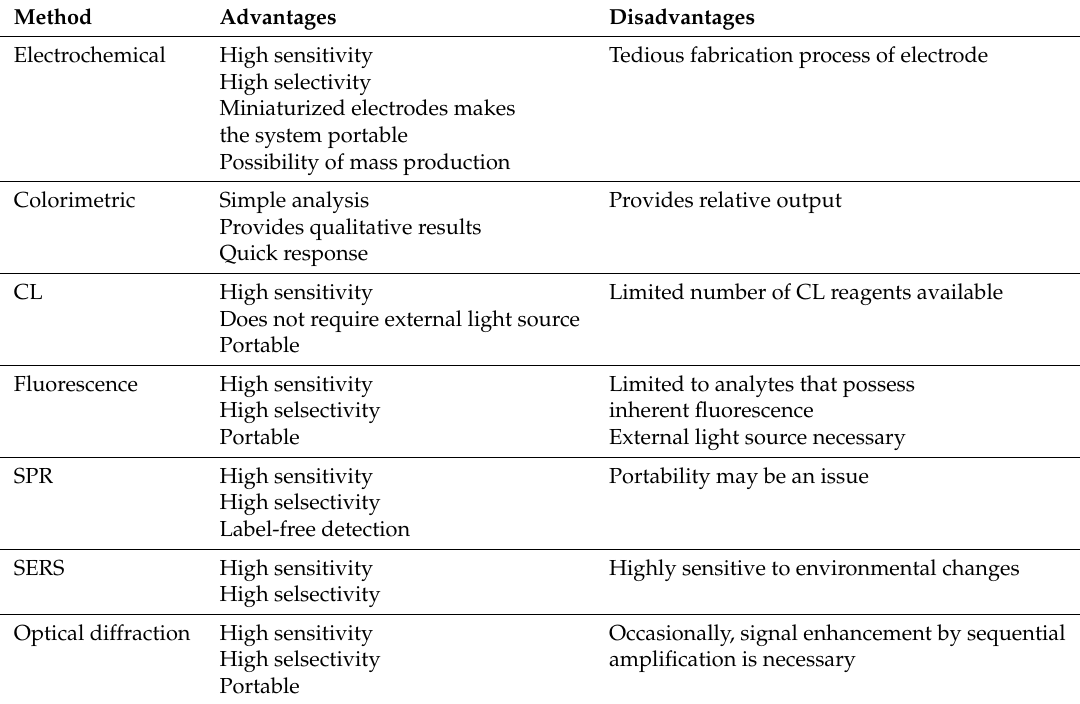
Table 6. Advantages and disadvantages of detection